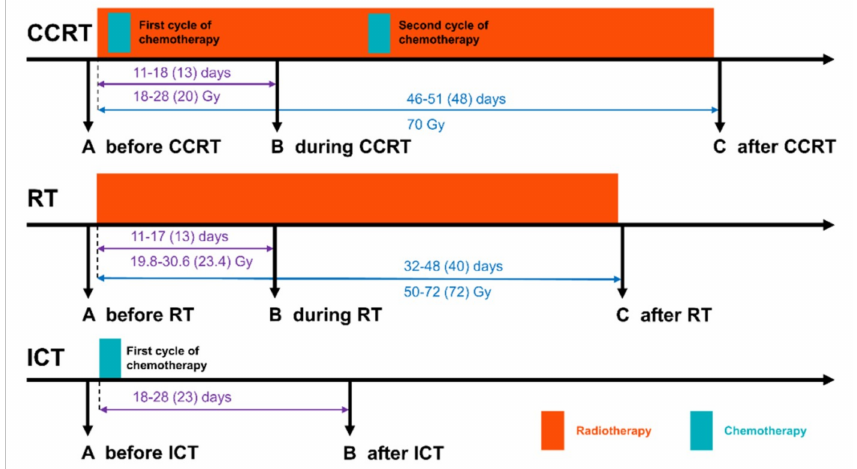
Figure 1. Schematic representation of treatment schemes included in the study: CCRT (concurrent chemo-radiotherapy), RT (radiotherapy), and ICT (induction chemotherapy). Marked are numbers of days and received doses between the start of the treatment and sample B or sample C (minimum-maximum and median in the parentheses).